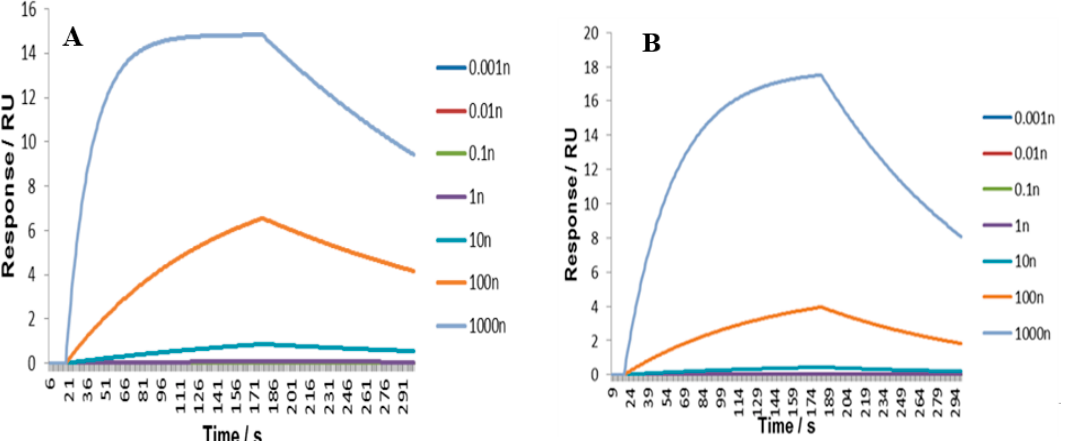
Figure 2. Surface Plasmon resonance (SPR) analysis of ( A ) florfenicol binding by florfenicol nanoMIP and ( B )